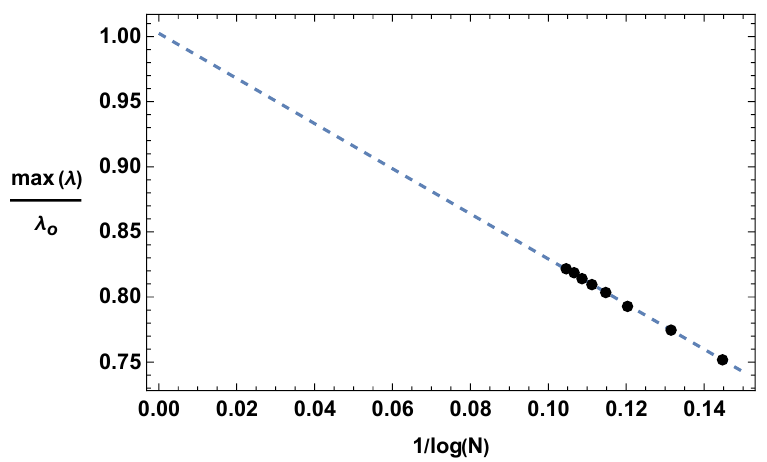
Figure 3 . Black dots are numerical results for the maximal singular value of Y cl { 1 , 2 , 4 , 6 , 8 , 10 , 12 , 14 } × 10 4 . The maximal singular value is divided by the analytical prediction λ o given in (4.34). A linear fit of the data to max( λ ) /λ o = A + B/ log( N ) yields the dashed line shown, consistent with convergence to the predicted value as N → ∞ . The results for the ratio max( λ ) /λ o do not depend strongly on the location x o of the